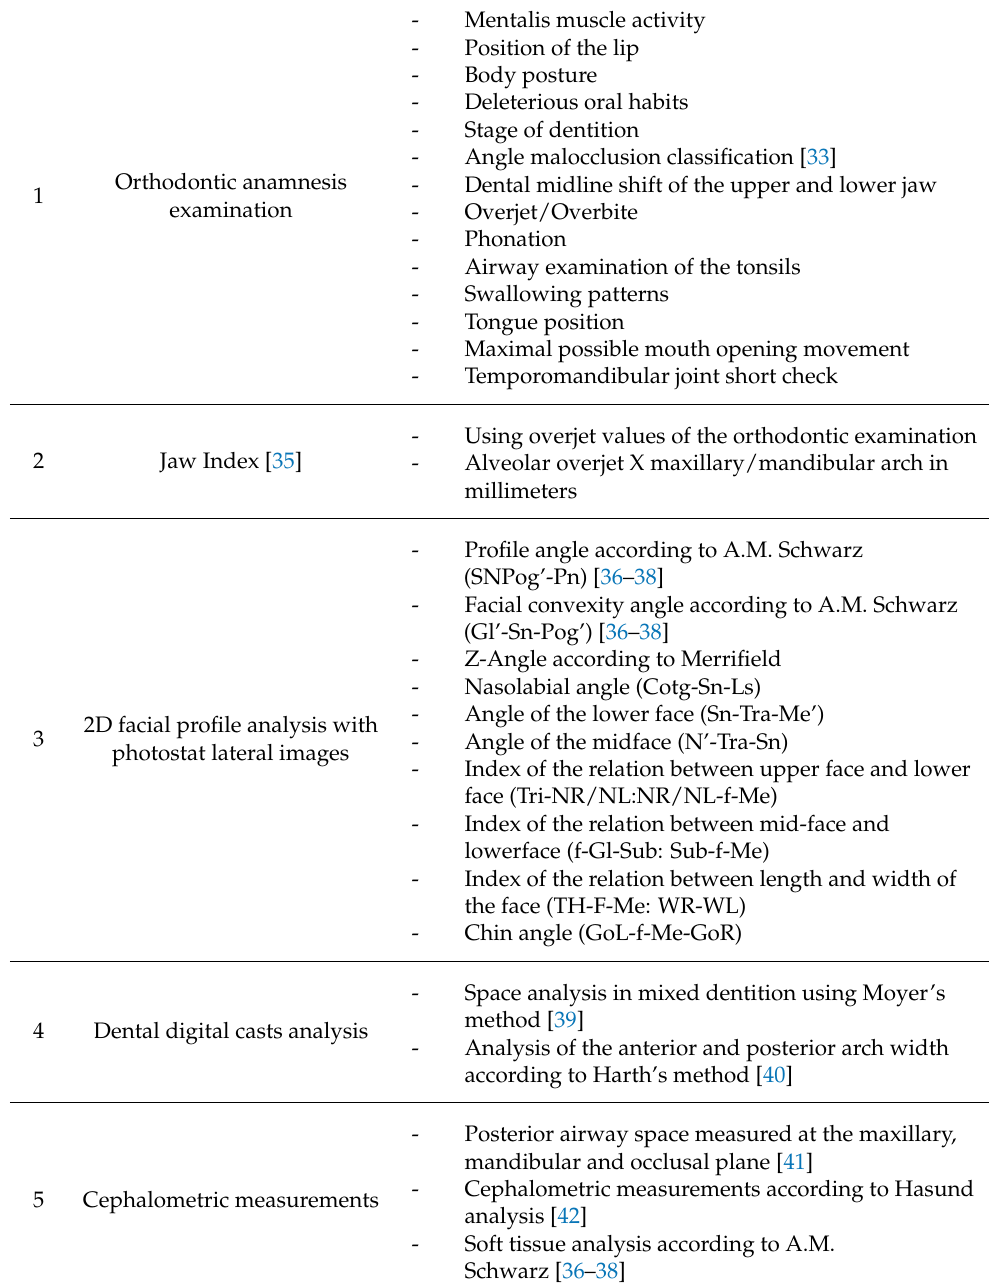
Table 1. Orthodontic